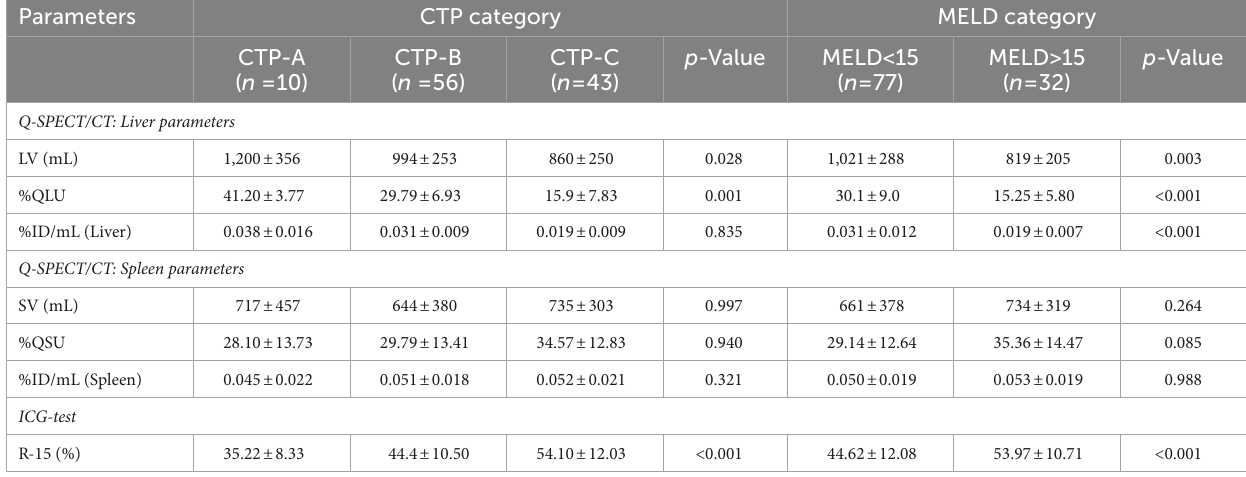
TABLE 1 Q-SPECT/CT and ICG parameters among prognostic categories in decompensated cirrhosis. Parameters